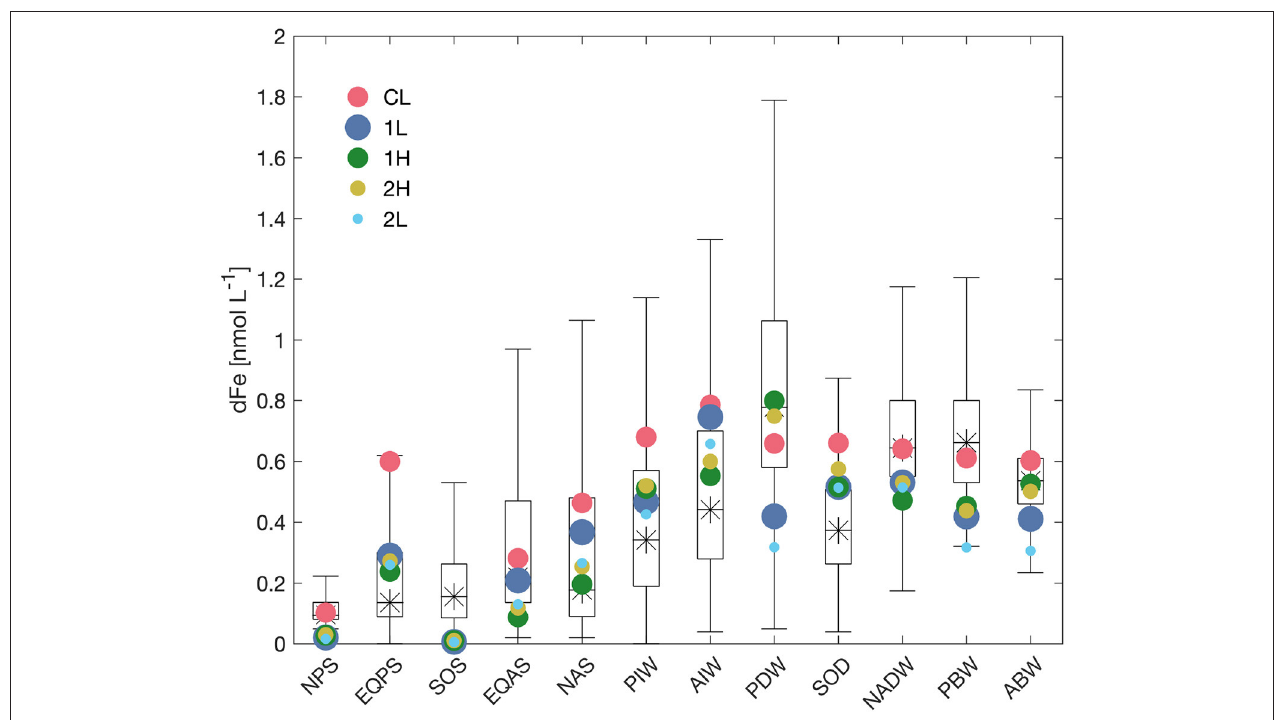
FIGURE 4 | Dissolved iron concentrations for the 12 model boxes from model results (colored dots) vs. derived from GEOTRACES IDP2 data (boxplots). The star shows the median concentration from the observations, the box ranges from the lower quartile to the upper quartile, and the lines extend to a length of 3/2 the interquartile range or to the maximum or minimum of the data (whichever is smaller) above the upper or below the lower quartile. The more extreme dissolved iron concentrations from stations near hydrothermal vents enter in the calculation of the quantiles, but are not shown in the whiskers. Red dots show results from the model with constant ligand concentration (run CL ), blue with one prognostic ligand (run 1L ), green from the model run with one very long-lived ligand (run 1H ), and yellow and cyan from the model runs with two prognostic ligands (run 2H and 2L ,